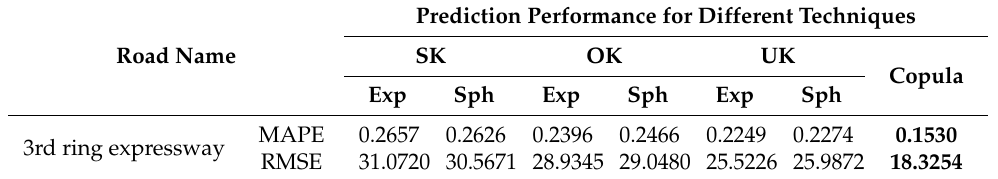
Table 9. Comparison between copula and kriging with MCR at 9:00 (timestamp = 270) 4 on June 2015.